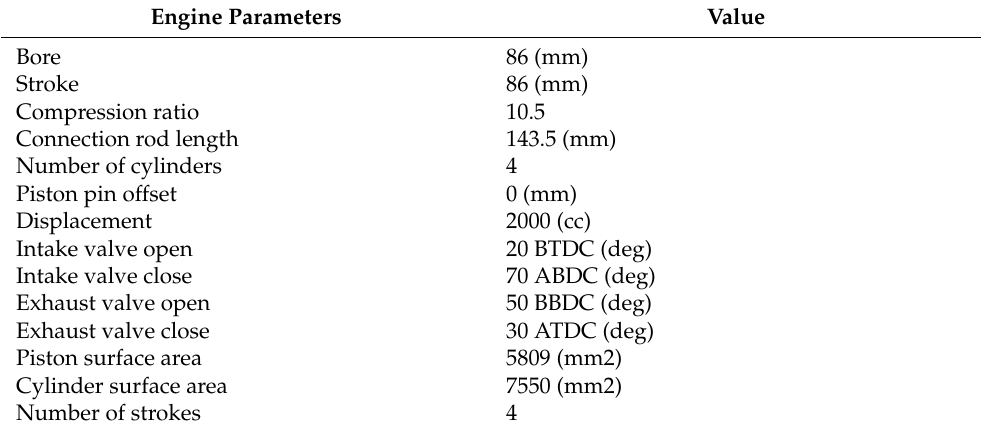
Table 3. Gasoline PFI engine